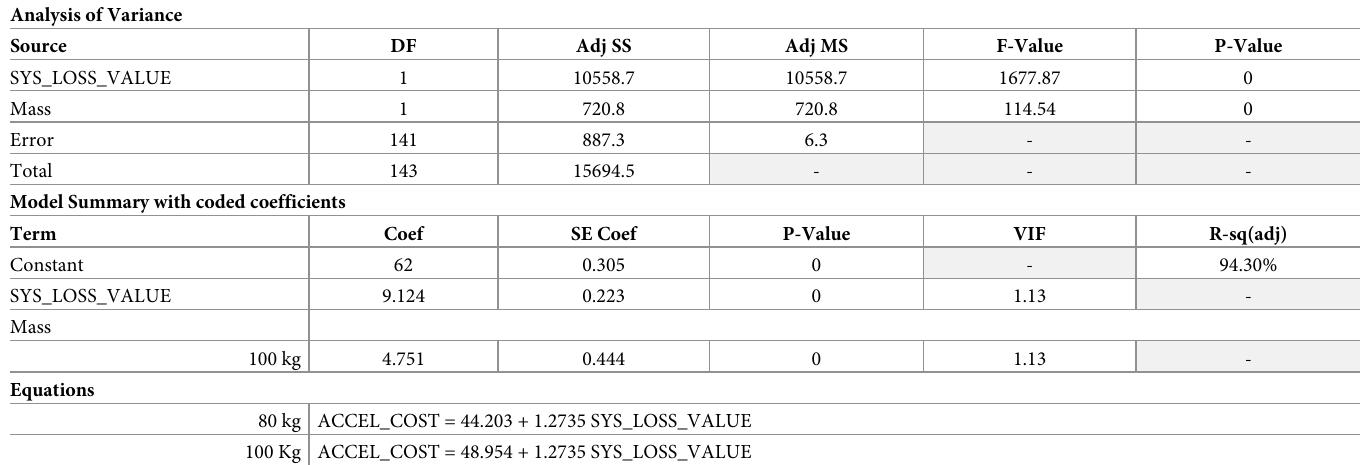
Acceleration cost: Fixed-wheel turn For fixed-wheel turns, the acceleration cost models entered System Loss, Yaw inertia, Weight Distribution and Mass. The results of the initial model identified System Loss and Weight Dis- tribution as predictors. The subsequent model run using these predictors ( Table 7 ) yielded an output equation with R 2 = 85%. The coefficients reflect the importance of energy loss as a Table 6. Accel cost: Straight trajectory. Analysis of Variance